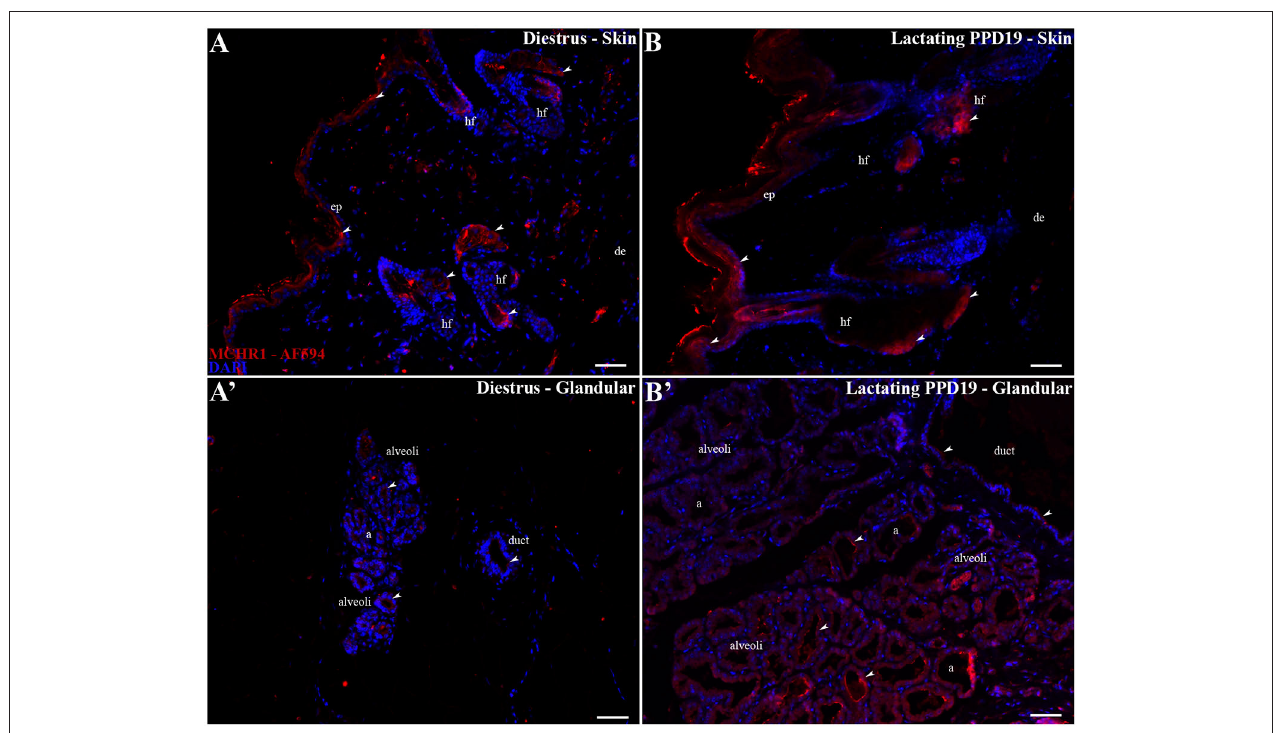
FIGURE 3 | MCHR1 immunoreactivity in the skin and parenchyma of the rat mammary gland tissue. Wide field fluorescence photomicrographs of sagittal mammary gland slices from diestrus and PPD19 rats ( n = 3/group) submitted to indirect immunofluorescence for MCHR1 (red) and counterstained with DAPI nuclear stain (blue). (A,B) In the skin of mammary gland the MCHR1-ir cells are found in the epidermis, distributed all over the basal, spinous, granular layers, and cornified layer. Some of the accessory epidermal structures of the skin were labeled, such as the fat cells of the sebaceous gland and cells of the hair follicle. (A’) The undeveloped parenchyma on diestrus phase shows few or absence immunolabeling for MCHR1. (B’) The parenchyma on PPD19 display MCHR-ir cells bordering and into the luminal part of the acini and ducts. The MCHR1-ir cells are indicated by white arrowheads. a, acini ; ep, epidermis; de, dermis; hf, hair follicle; d, duct. Scale bar: 50 µ